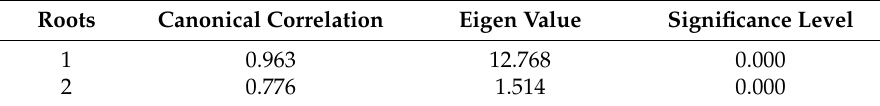
Table 2. Canonical Correlation Analysis and Test